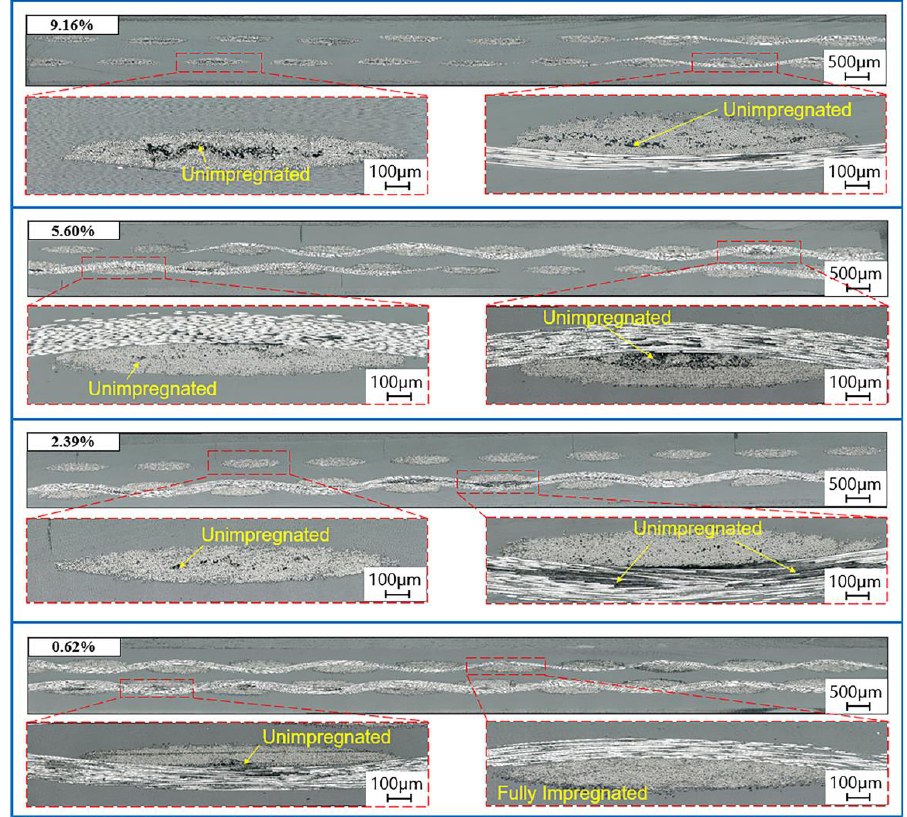
Figure 7. Section impregnation morphology of laminates with different void contents.